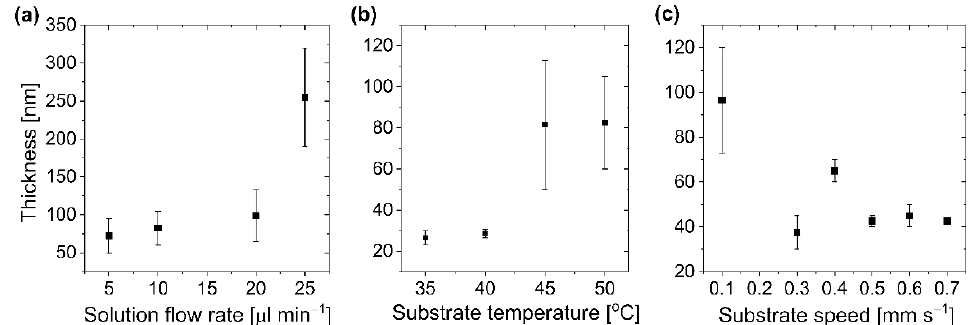
Figure 2. Thickness (including PEDOT:PSS) of slot-die-coated EMLs (PVK:PBD + 2 wt.% Ir) depos- ited at different process parameters from anisole. ( a ) Thickness vs. solution flow rate (nozzle-substrate distance: 100 μm, temperature: 50 °C, substrate speed: 0.3 mm s −1 ); ( b ) thickness vs. substrate temperature (nozzle –substrate distance: 100 μm, flow rate: 10 μL min − 1 , substrate speed: 0.3 mm s −1 ); ( c ) Thickness vs. substrate speed (nozzle –substrate distance: 100 μm, temperature: 50 °C, flow rate: